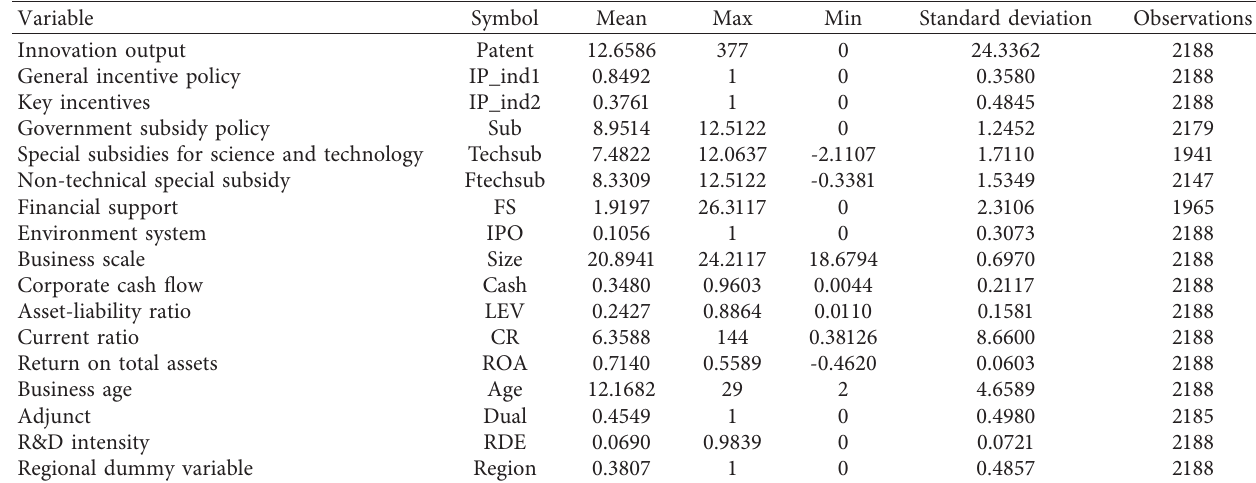
Table 2: Descriptive statistics of major